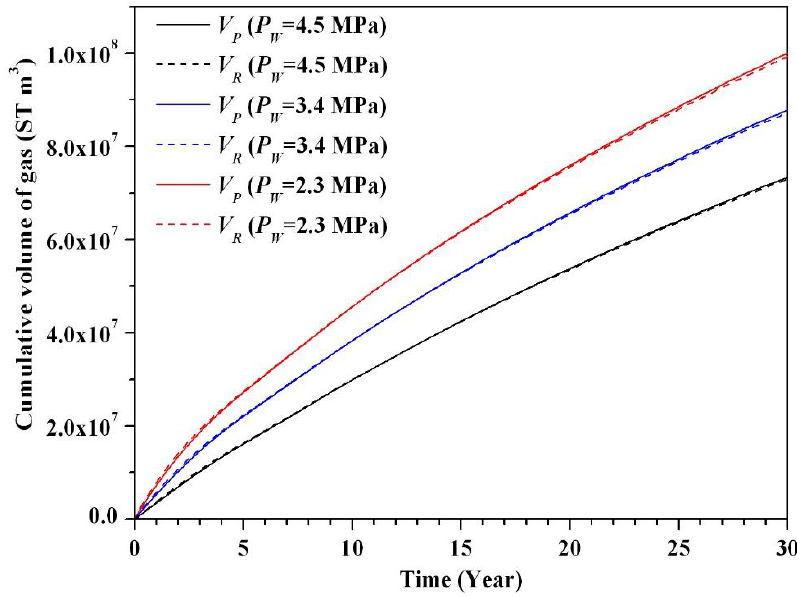
Figure 12. Sensitivity to the production pressure ( P W ): evolution of V P and V R overtime.